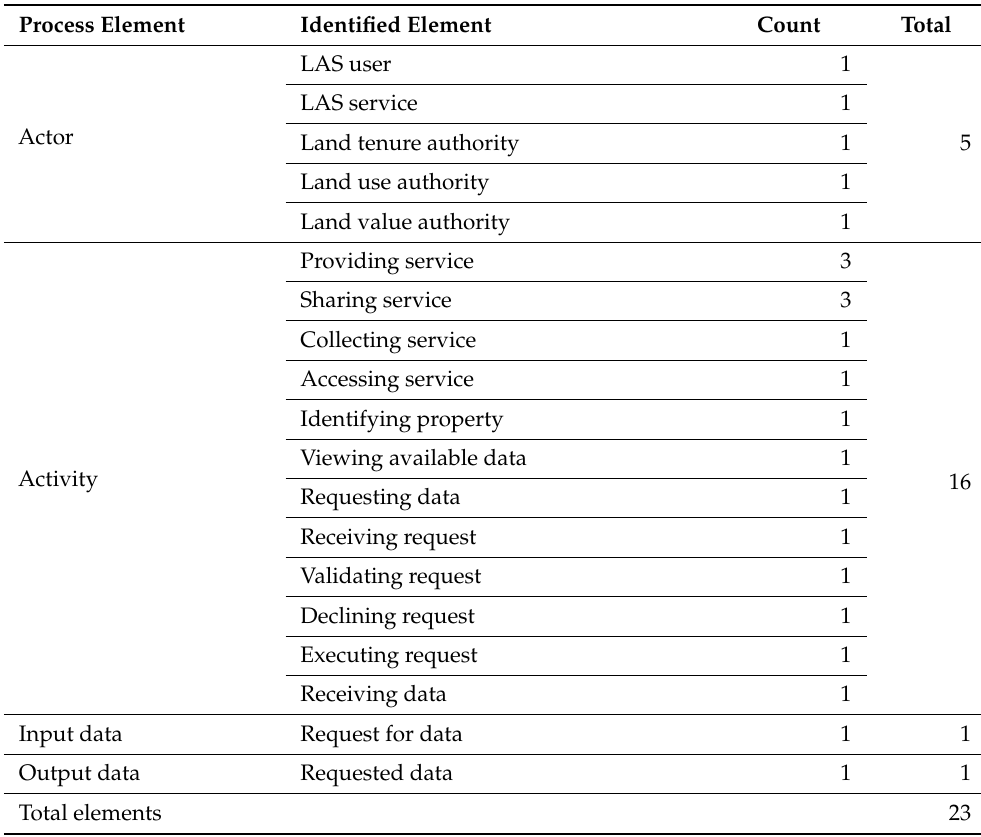
Table 3. Identified elements of the improved process. Source: Own